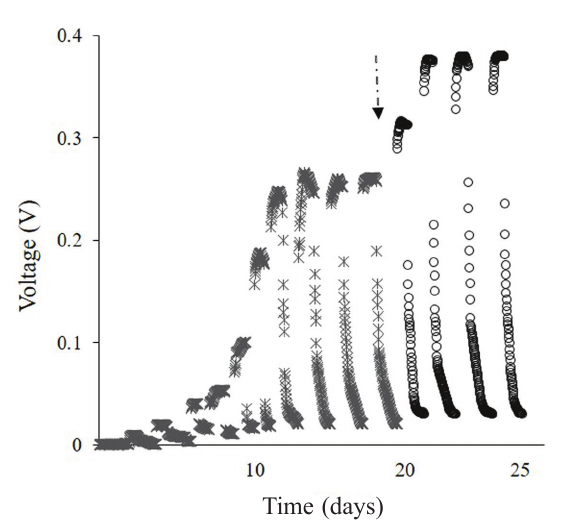
Time Fig. 2 – Voltage output of the CW-MFC at 1000 Ω in fed batch experiment with phosphate buffer (light black star), and potassium permanganate (black round) as catholytes. Arrow indicates the replacement of catholyte.